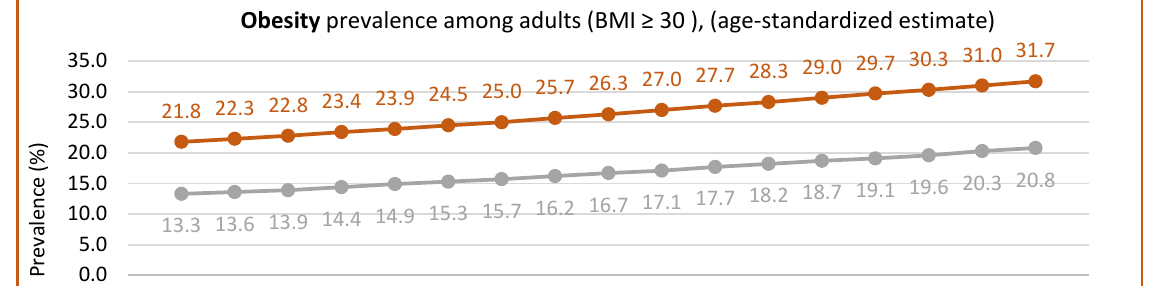
Figure 6. The prevalence of obesity in adults (BMI ≥ 30) (age-standardized estimate) UAE trend (1999 – 2017). Source: https://www.who.int/data/gho/data, http://www.healthdata.org/results/country-profile (accessed on 5 December 2022) [33,35].